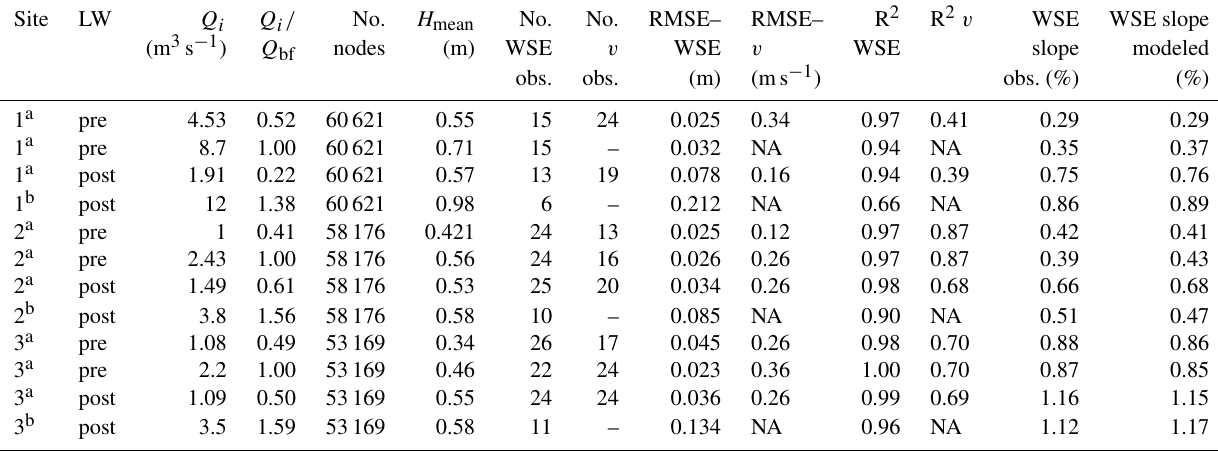
Table 2. Nays2DH model parameters and calibration results for pre- and post-large-wood (LW) models for different discharge ( Q i ) levels. Fractional bankfull discharge ( Q i /Q bf ), average model depth ( H mean ), number of water surface elevation (WSE) and velocity ( v ) observa- tions taken, root mean square error (RMSE), R 2 for WSE, and time-averaged v are indicated for calibration runs when available along with observed and modeled WSE